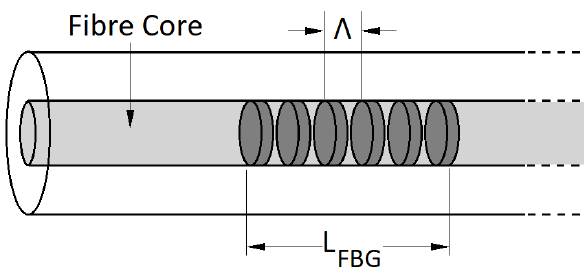
Figure 1. Typical fiber Bragg grating (FBG) sensor containing gratings in its core. L FBG is the length of the grating, and Λ is the grating